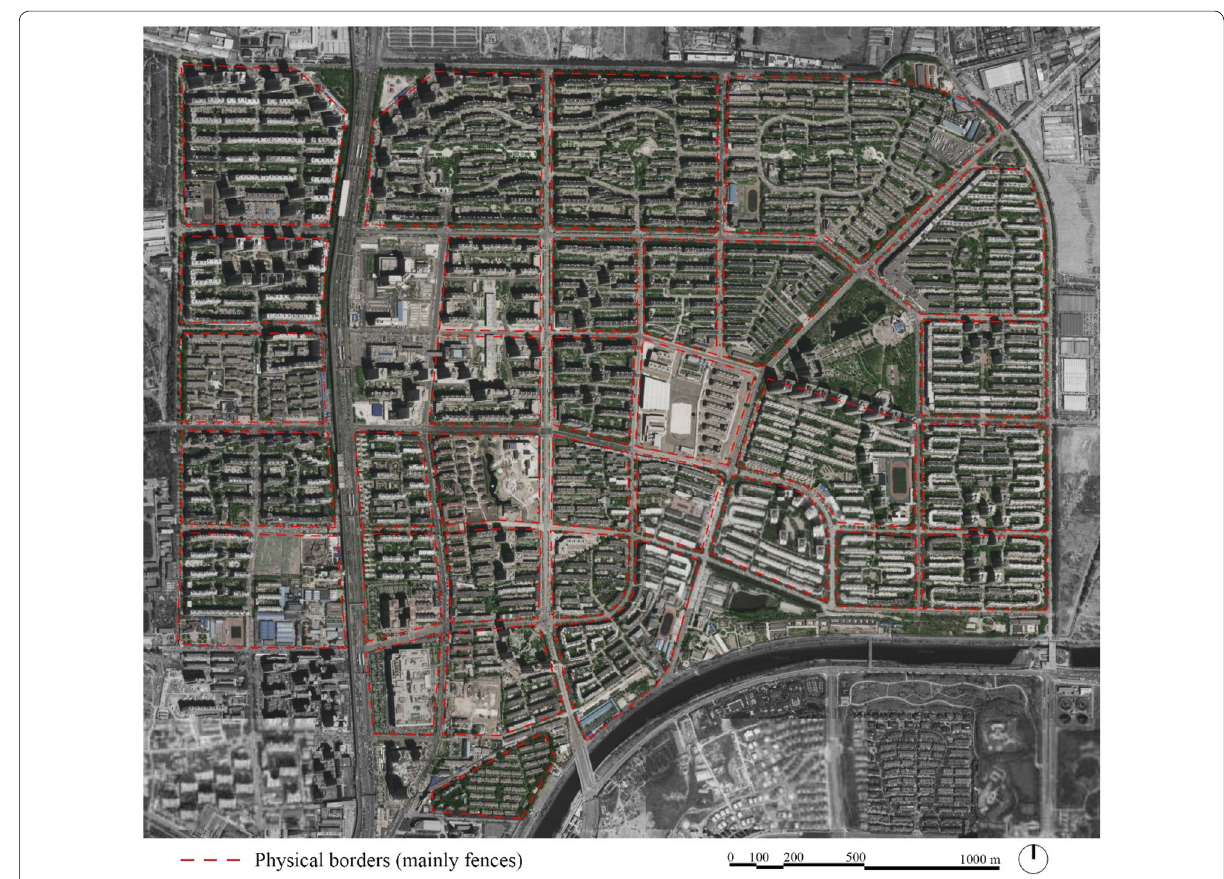
Fig. 6 Plan of the residential district of Tiantongyuan, Beijing. Almost all residential blocks are gated and surrounded by fences (Illustrated by the author based on Baidu maps,